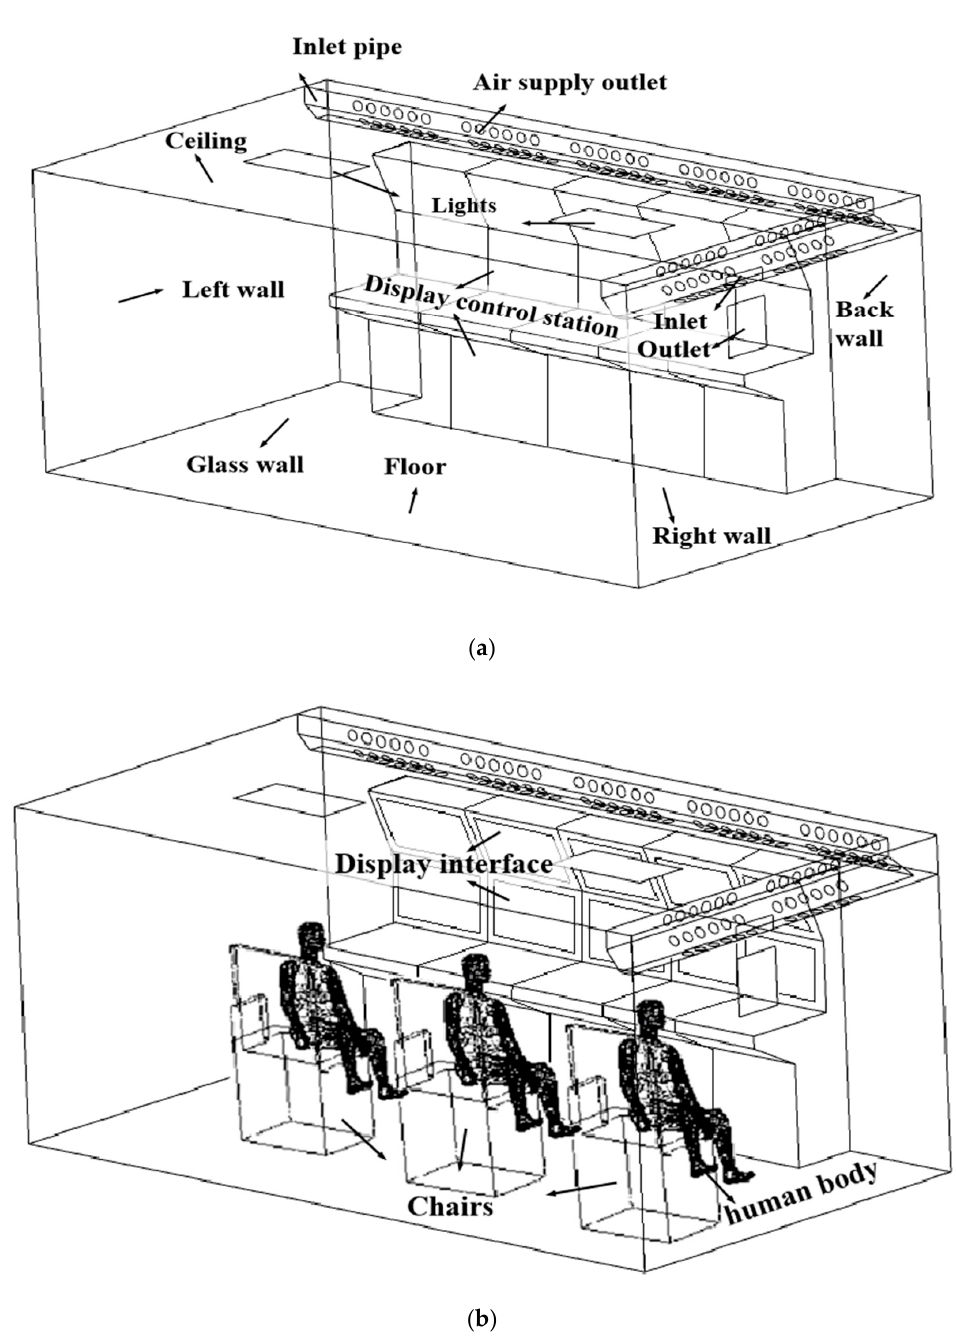
Figure 1. Geometric model of the cabin. ( a ) Square cabin geometry and layout. ( b ) Working stations and number of subjects.